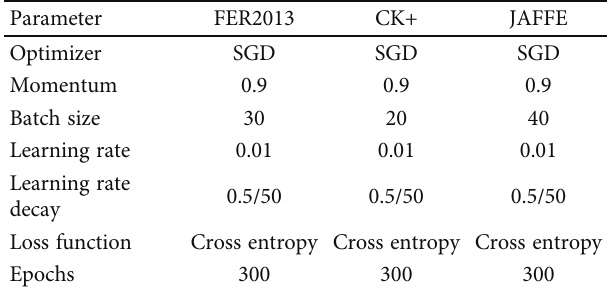
Figure 9: Depthwise separable shu ffl e method. Table 4: Experimental parameter